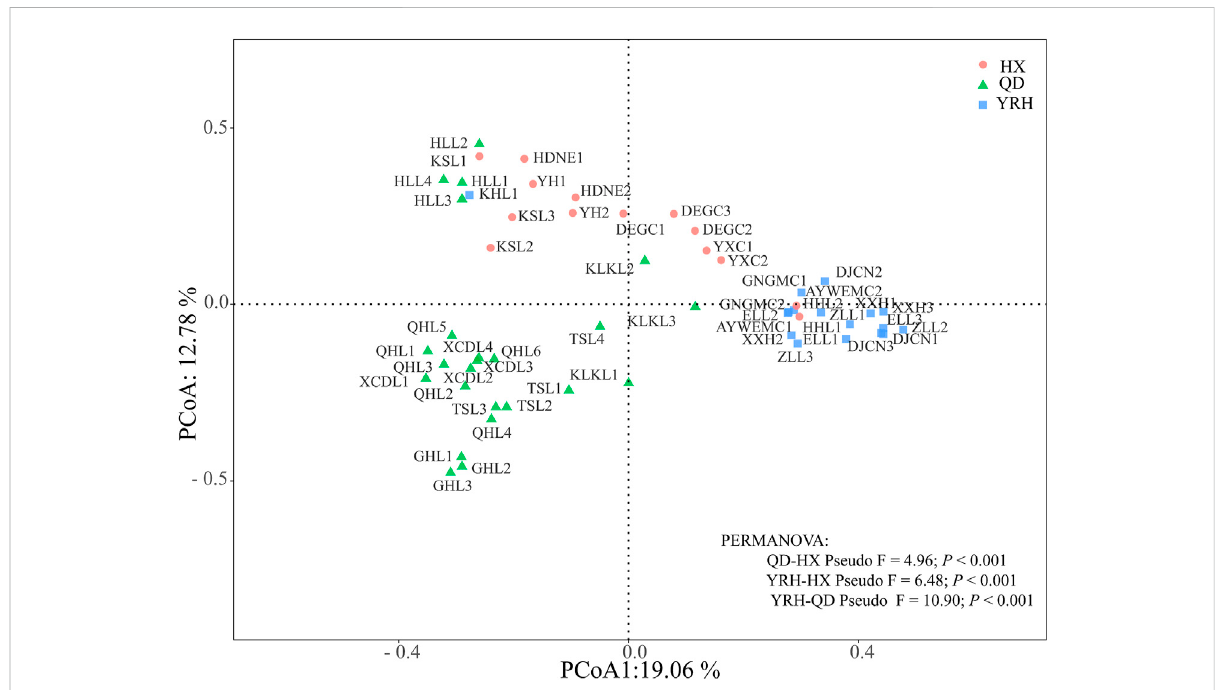
FIGURE 3 Principal coordinate analysis (PCoA) showing the compositional difference of bacteria community in the three regions based on the OTU